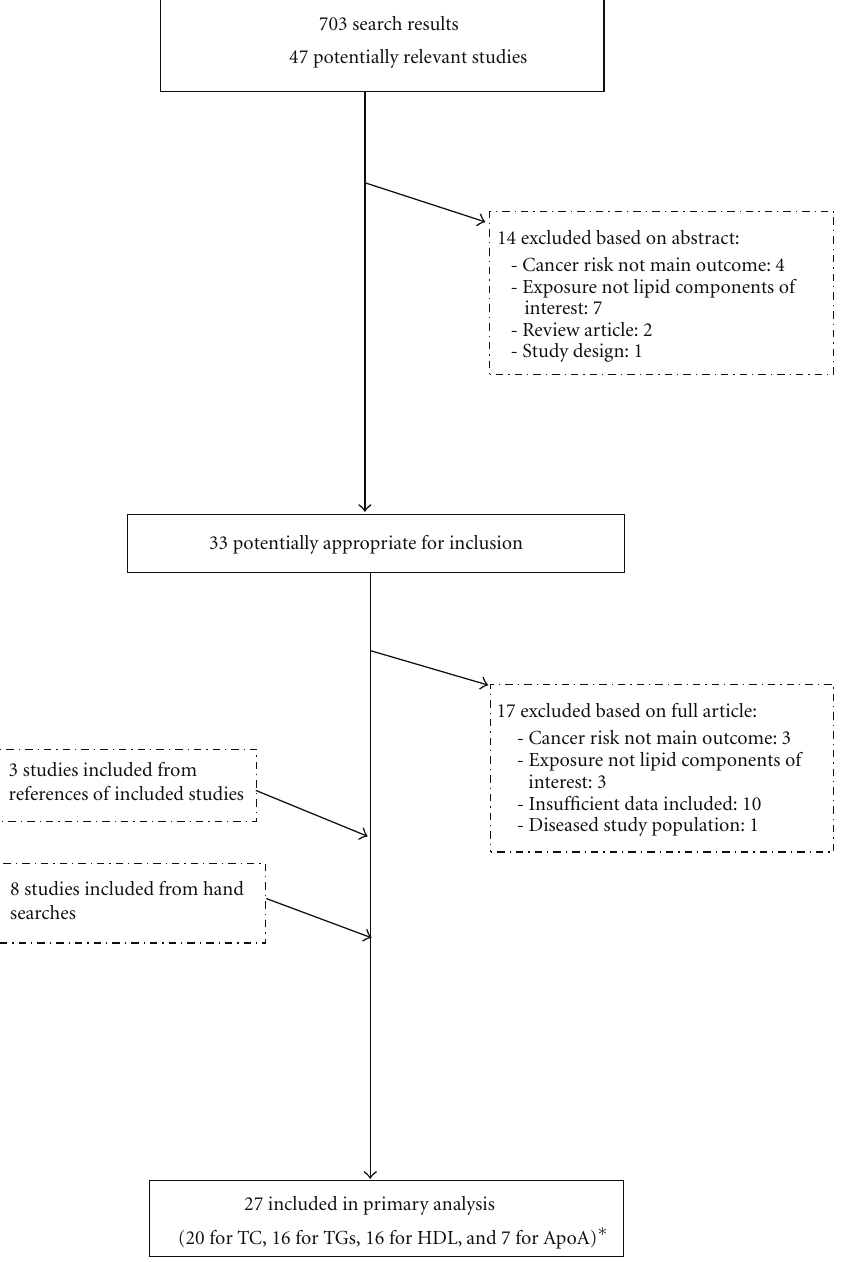
levels. e random-effects analysis, comparing overall